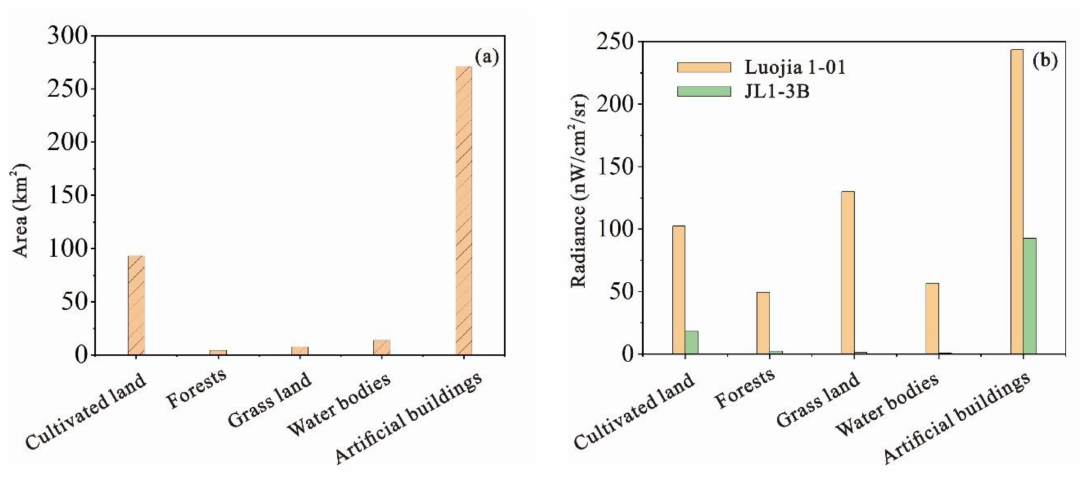
Figure 7. ( a ): The area corresponding to di ff erent land use types. ( b ): The average radiance of the